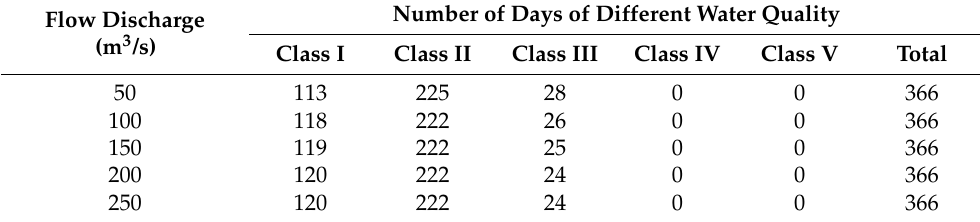
Table 4. The water quality classification at the outlet of the middle route in different water diversion